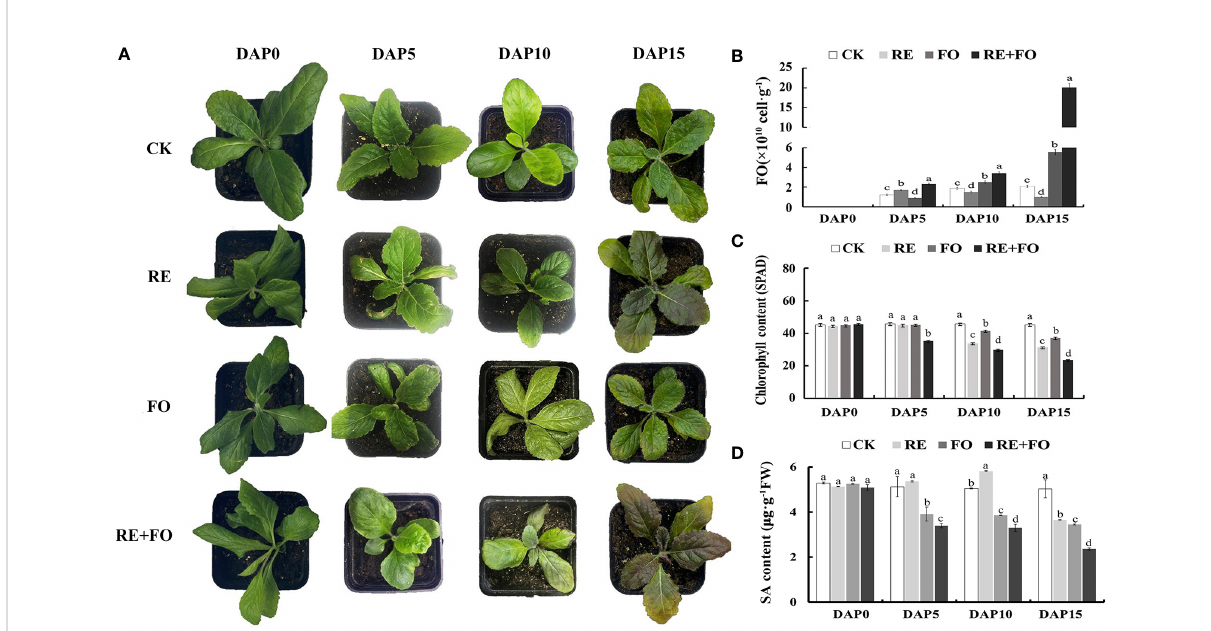
FIGURE 1 Morphological differences, Fusarium oxysporum proliferation, chlorophyll content and Salicylic acid (SA) content analysis of Rehmannia glutinosa seedlings under root exudates, F . oxysporum and comprehensive treatment of root exudates and F . oxysporum . (A) Phenotypic changes of R. glutinosa seedlings under root exudates, F . oxysporum and comprehensive treatment of root exudates and F . oxysporum . There were three biological replicates for each treatment; (B) Analysis of F.oxysporum proliferation in R. glutinosa rhizosphere soils under root exudates, F . oxysporum and comprehensive treatment of root exudates and F . oxysporum ; (C) Chlorophyll content analysis of R. glutinosa under root exudates, F . oxysporum and comprehensive treatment of root exudates and F . oxysporum . (D) SA content analysis of R. glutinosa under root exudates, F . oxysporum and comprehensive treatment of root exudates and F . oxysporum . DAP, Days after planting;